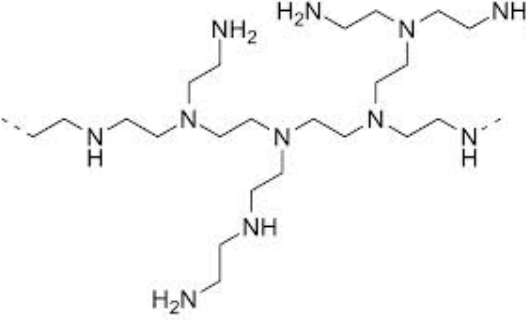
Figure 1. Chemical structure of HBPEI.